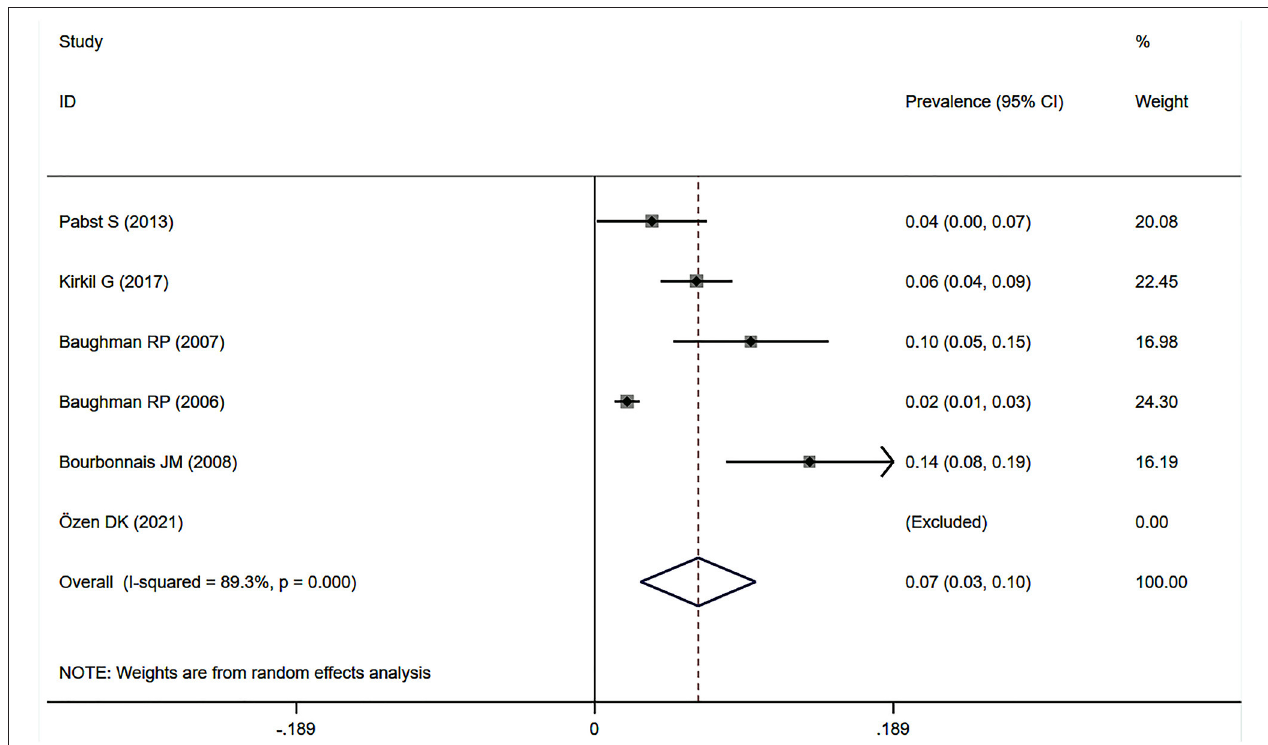
FIGURE 6 | Forest plot of the pooled prevalence of pre-capillary PH by RHC in general sarcoidosis population. PH, pulmonary hypertension; RHC, right heart catheterization.